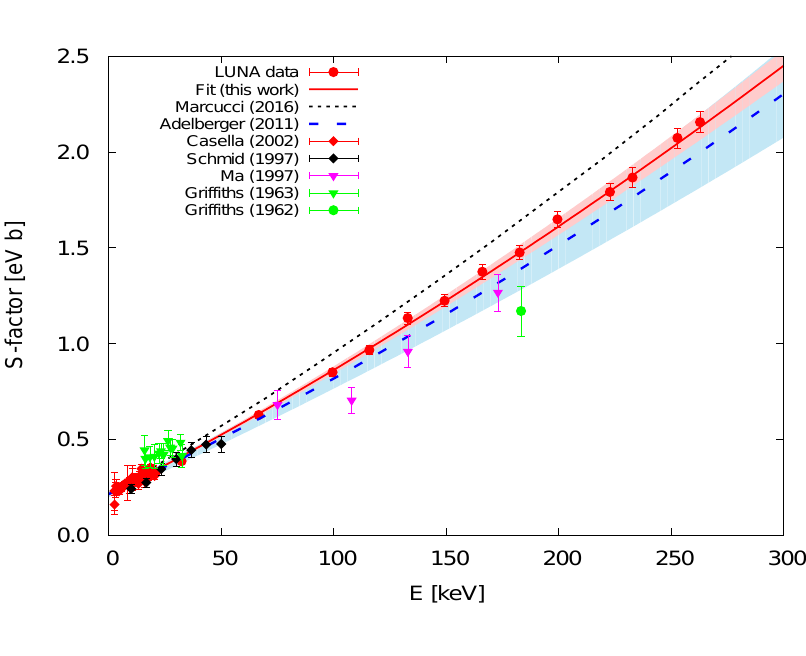
Figure 2: S-factor of the D(p, γ ) 3 He reaction; LUNA results are represented with filled red circles. Other experimental data are also shown. The best fit (red solid line) include all the reported experimental data. Band represents the 68% confidence